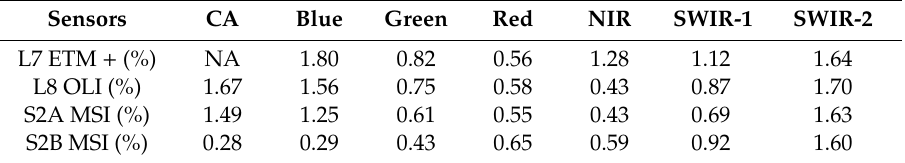
Table 12. Niger 1 random error (precision) between measured and simulated values. Sensors